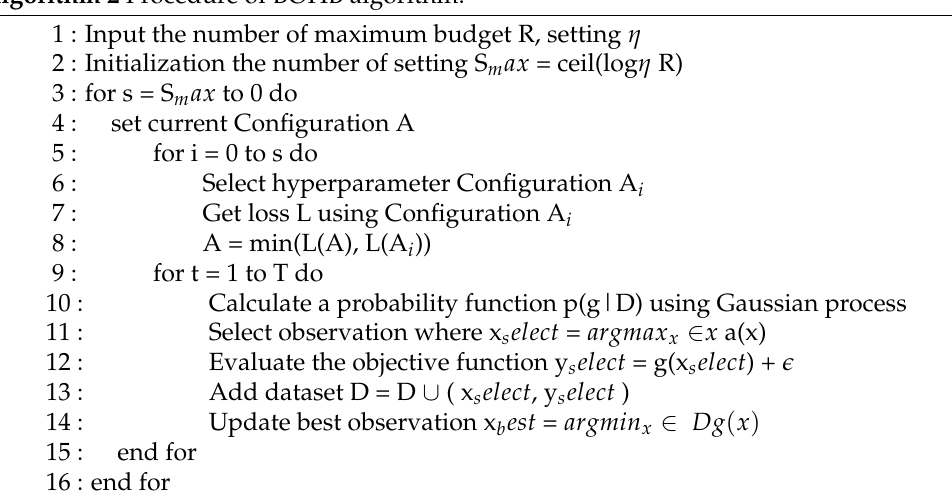
Figure 2. Costly feature selection and classification model based on the reinforcement learning algorithm. Q class denotes the optional action with which the feature selection and classification are performed. Without Q class , only the feature selection task is conducted. Algorithm 2 Procedure of BOHB